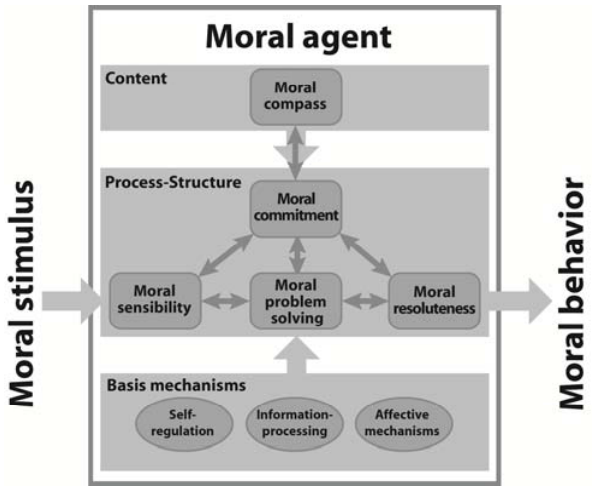
Figure 1. Outlining the components of Moral Intelligence. Moral commitment has a privileged